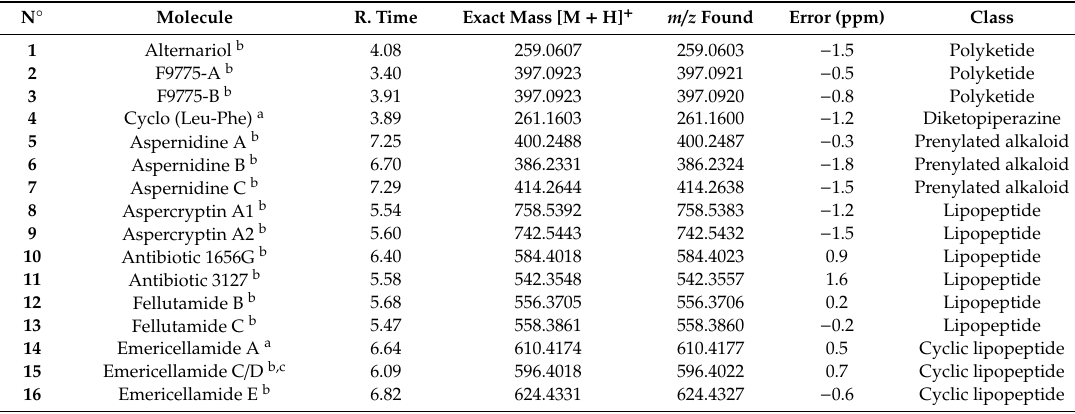
Table 1. Secondary metabolites identified from Aspergillus pachycristatus NRRL 11440. N